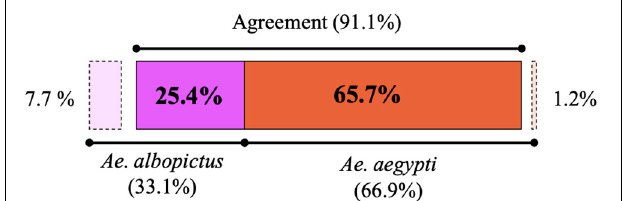
FIGURE 2 | Percentage of A. albopictus (purple) and A. aegypti (orange) individuals identified by morphological and molecular testing. The dotted lines mark the inconsistencies where individuals were initially assigned by morphology to a different species compared to the one detected by molecular methods, and the latter is the technique by which individuals were ultimately assigned for subsequent sequence analysis.